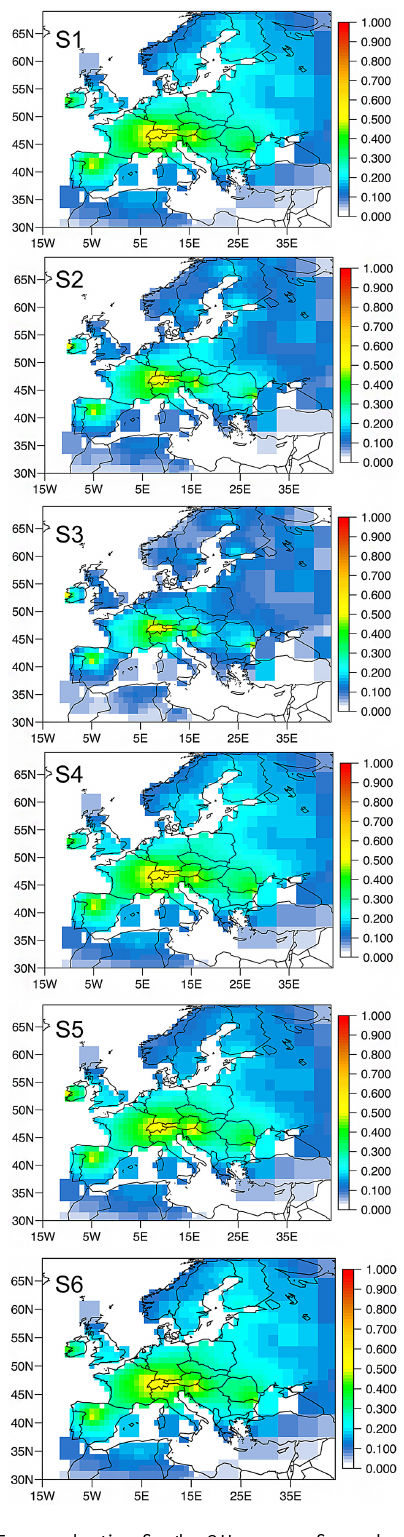
Figure 6. Error reduction for the CH 4 fluxes for each of the sensi- tivity tests.